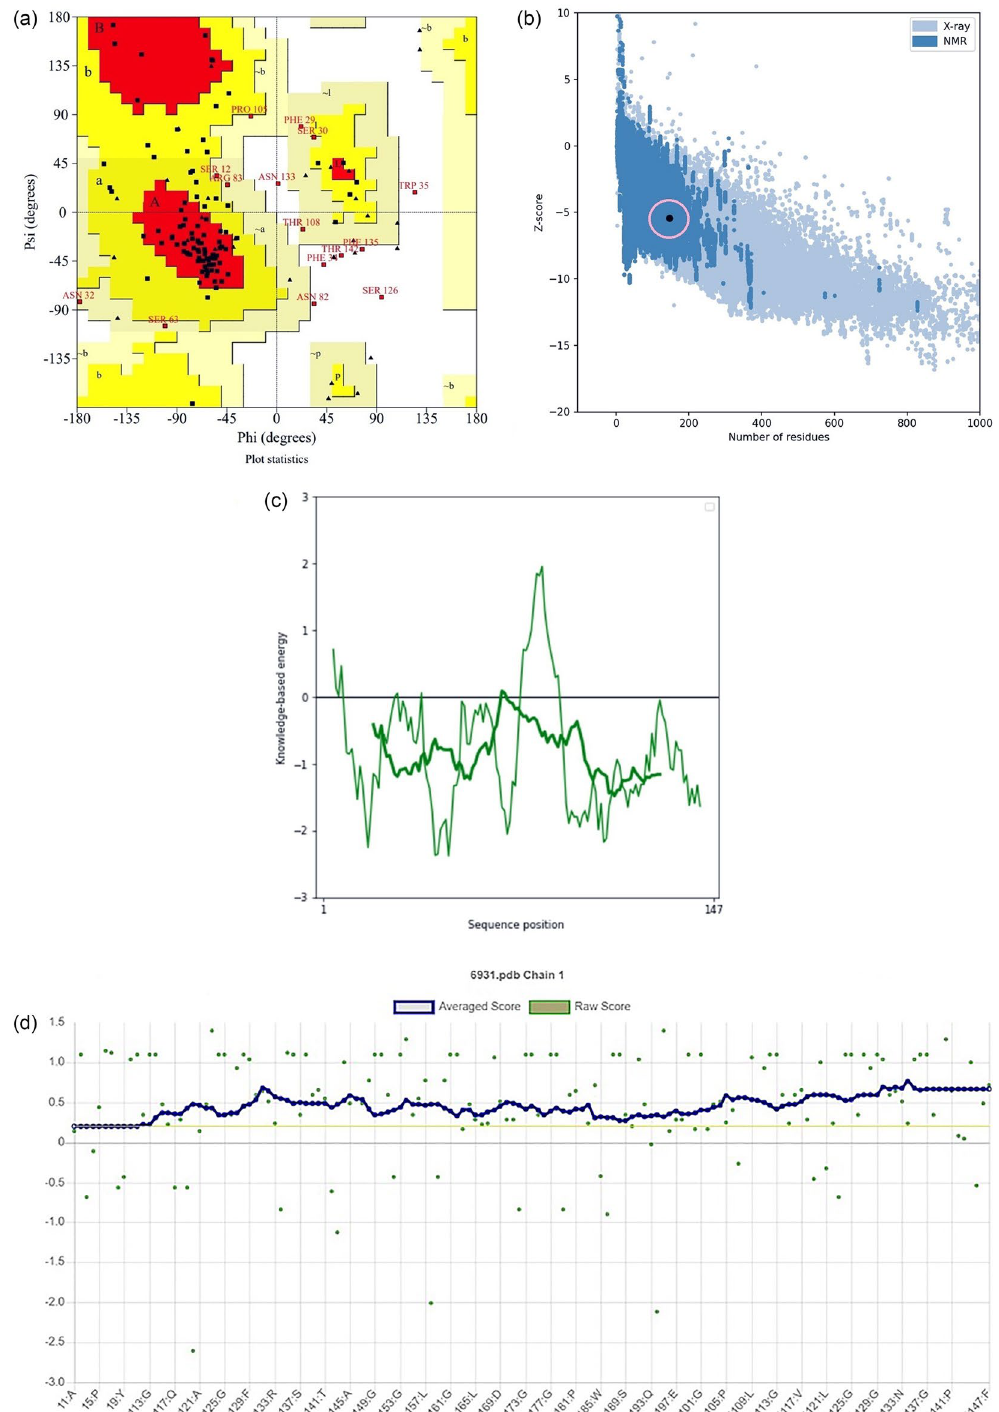
Figure 6. ( a ) Validation of leish 21protein structures by a Ramachandran plot; ( b and c ) ProSA-web z-score plot and local model quality for 3D structure of leish21protein structures, respectivel; ( d ) Verify3D method to evaluate a 3D model of final